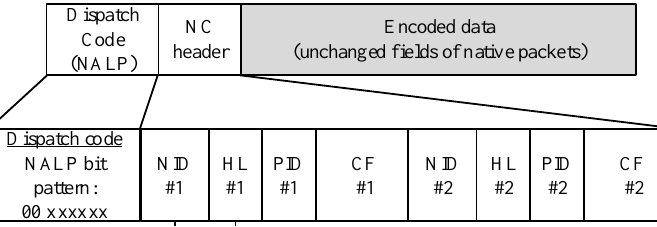
Algorithm 2. NC Buffer Timers Control